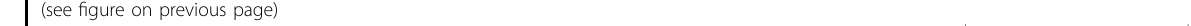
lymphatic vessels in UUO mice (400×) ( A ) and ADR mice (400×) ( B ). C Primary bone-marrow-derived macrophages (BMDMs) were isolated and induced to form M0, M1, and M2 macrophages in vitro, and western blot analysis suggested that compared to M0 and M2 cells, M1 macrophages predominantly expressed lymphatic vessel markers (Prox-1, LYVE-1, and podoplanin). D Relative mRNA expression of podoplanin, Prox-1, LYVE-1, VEGFR3, and VEGF-C was measured in BMDM subpopulations by real-time PCR; * p < 0.05, ** p < 0.01 versus M0 or M2 macrophages. E Immuno fl uorescence results showed that M1 markers (inos) colocalized more with lymphatic vessel markers (LYVE-1 and podoplanin) than M0 and M2 (CD206), and lymphatic vessel markers (LYVE-1 and podoplanin) tended to be expressed in M1 macrophages (400×). Merged representative images also show nuclei (DAPI in blue). N =